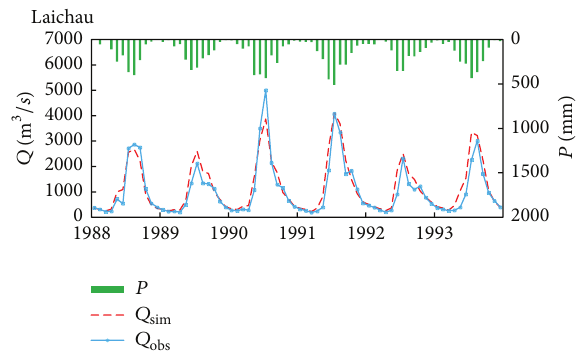
Figure 6: Comparison of observed and simulated monthly stream- flow in the DRB (Laichau station).